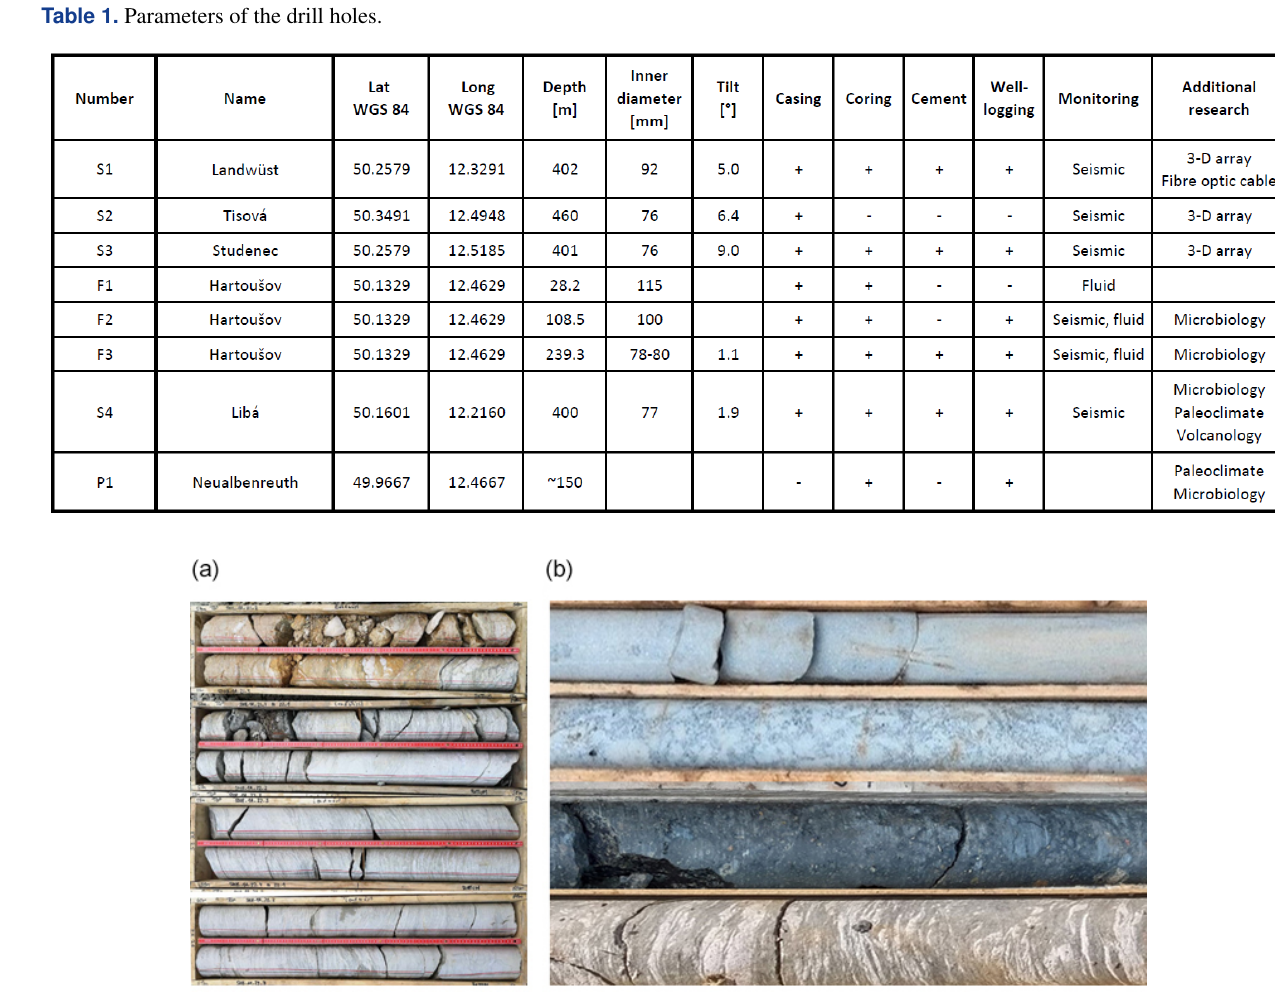
Figure 5. Panel (a) presents an example of drill cores stored in wooden boxes that have been marked and labeled, showing phyllitic core from S1. Panel (b) presents an example of different lithologies in hard rocks, showing (from top to bottom) granite from S4, granite from S4, basalt from S4 and phyllite from